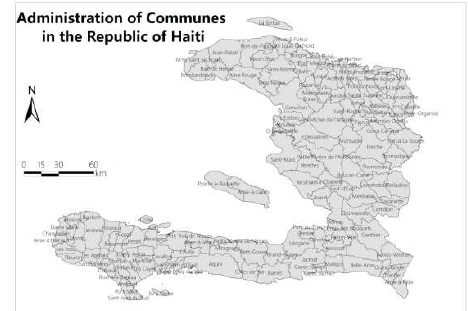
Figure 1. Administration of communes in the Republic of